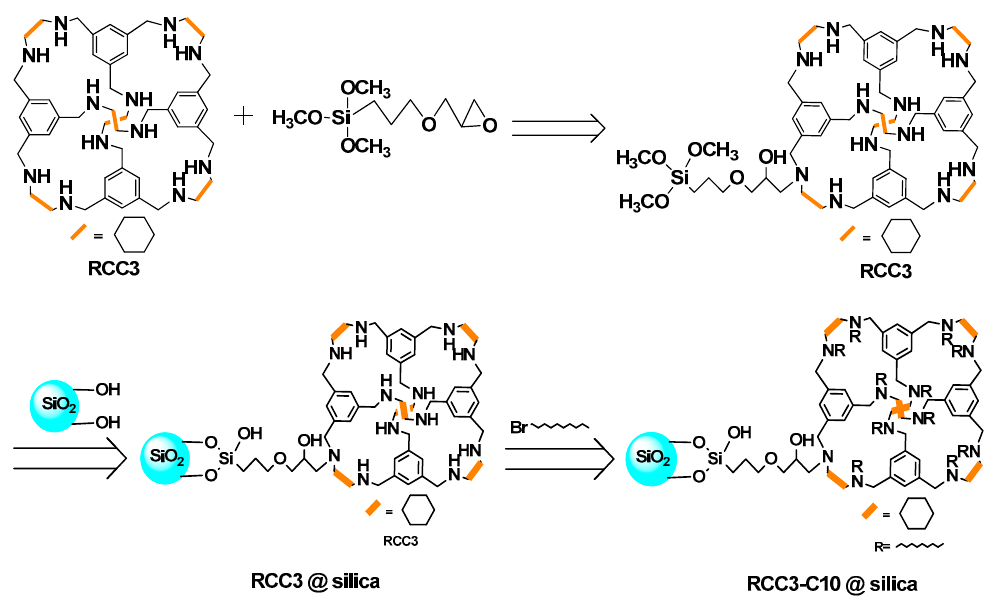
Figure 6. Preparation process of RCC3-C10@silica stationary phase.